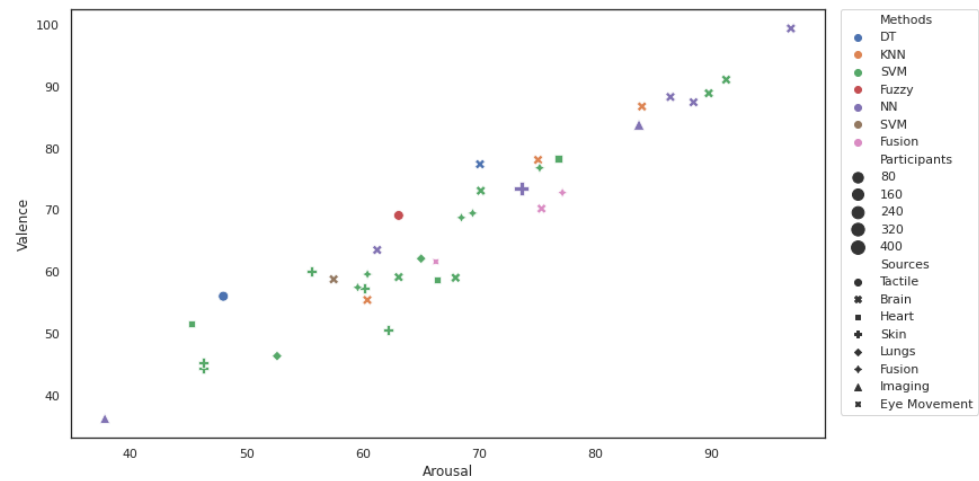
Figure 6. Scatter plot for the Valence-Arousal emotional